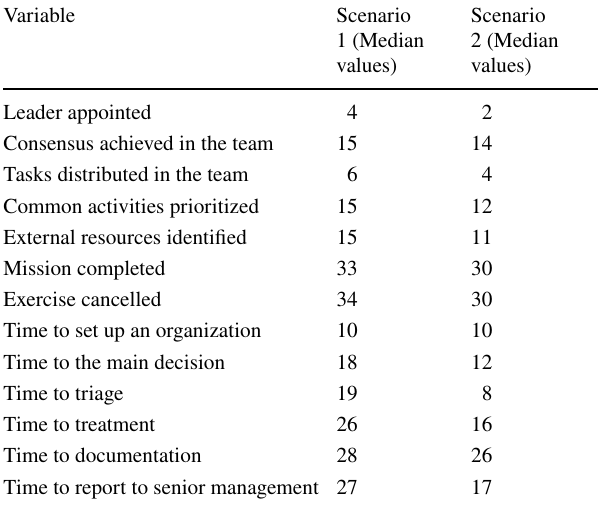
Table 2 Participants’ observation model of performance and practical progress between the two scenarios with a focus on time ( n = 100) Variable Scenario